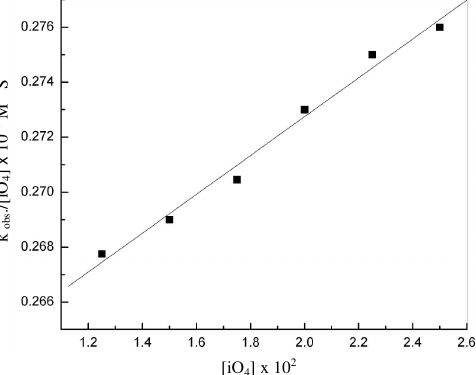
Figure 1. The periodate dependence of observed rate constant for [Co ll HDTQA(H reaction system